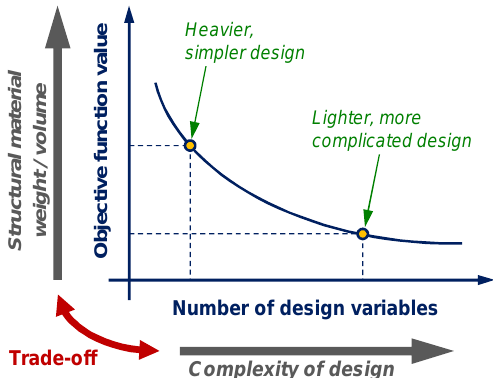
Figure 2. Conceptual graph of the trade-off relation between the number of design variables and the best-attainable objective function